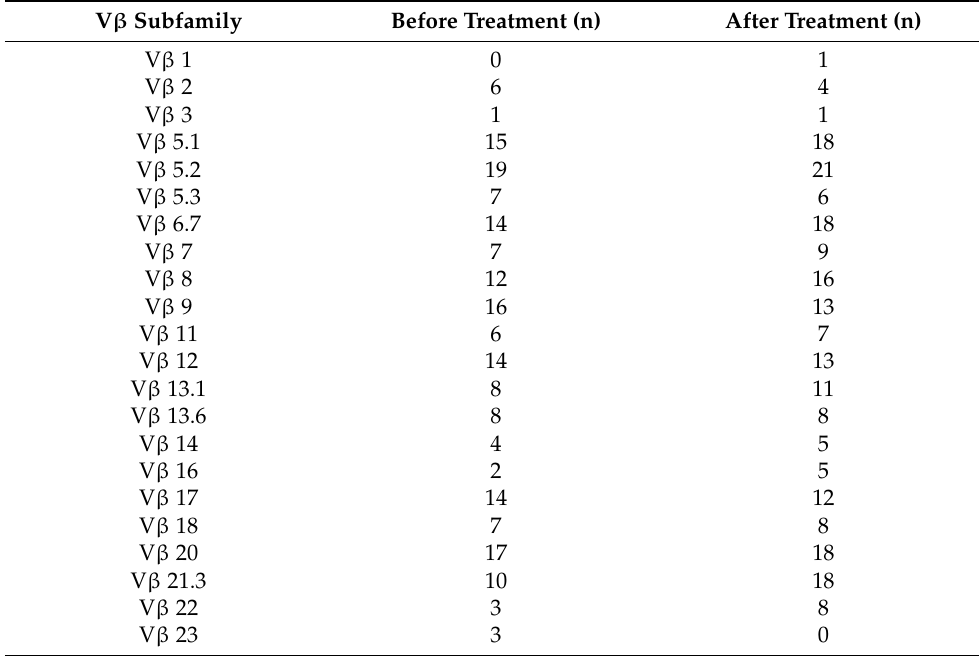
Table 2. The CD8 + T cells’ TCR V β oligoclonal usage tendency testified by flow cytometry. V β Subfamily Before Treatment (n) After Treatment (n) V β 1 0